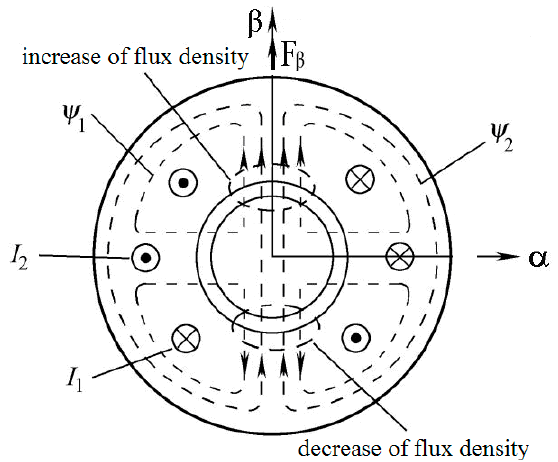
Figure 1. Suspension force generation schematic diagram.